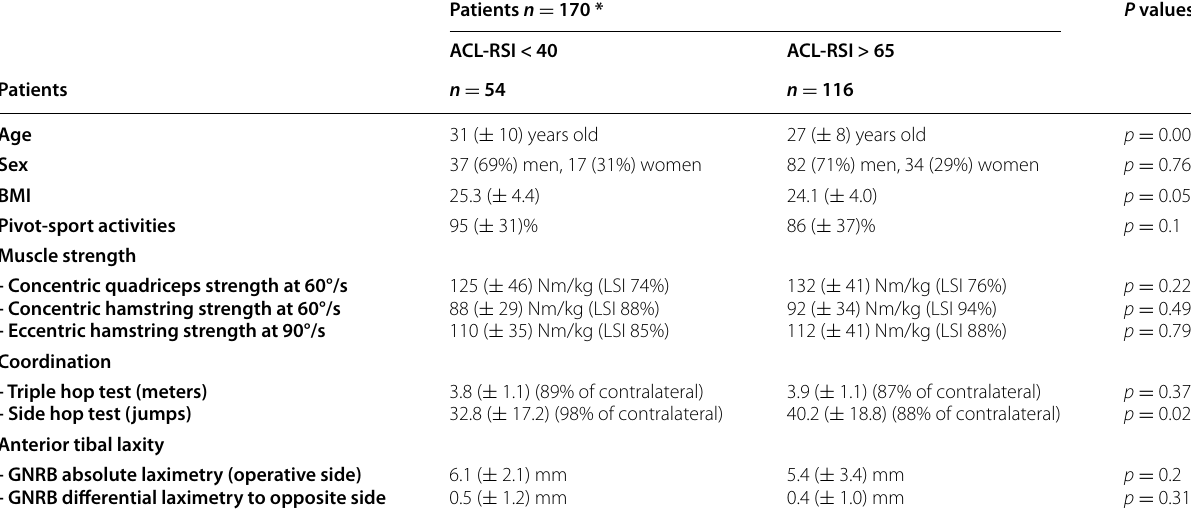
* Exclusion of 133 patients who had intermediate ACL-RSI score between 40 and 65 BMI Body mass index, ACL-RSI Anterior cruciate ligament return to sport after injury, LSI Limb symmetry